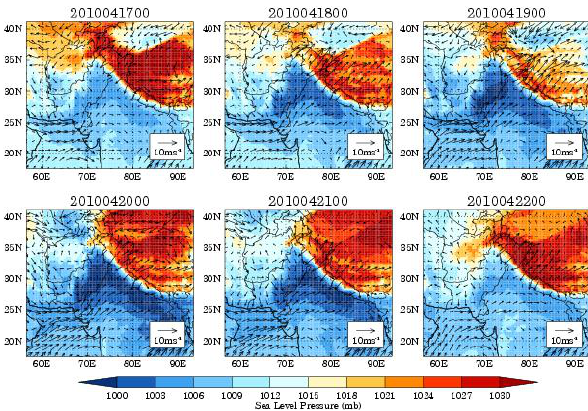
Fig. 2. Day-to-day variations in mean sea level pressure and 10m wind vectors over the model domain from 17 to 22 April 2010 at 00:00UTC. The wind vectors are shown every 5th grid point for